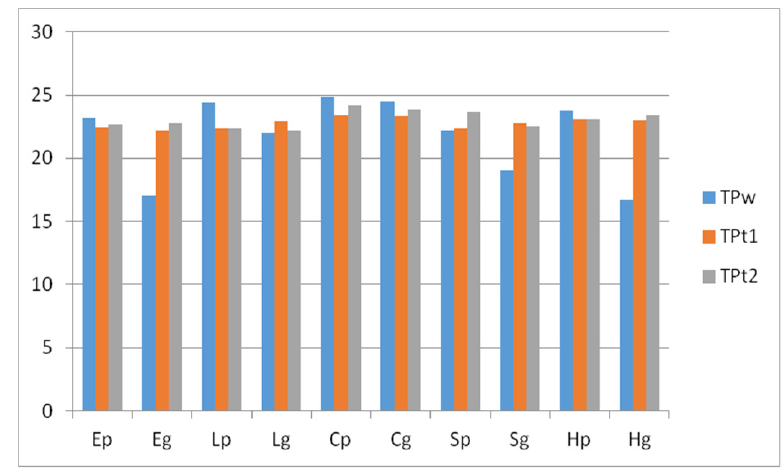
Figure 2. Mean values of the TP parameter, before and after thermal aging.